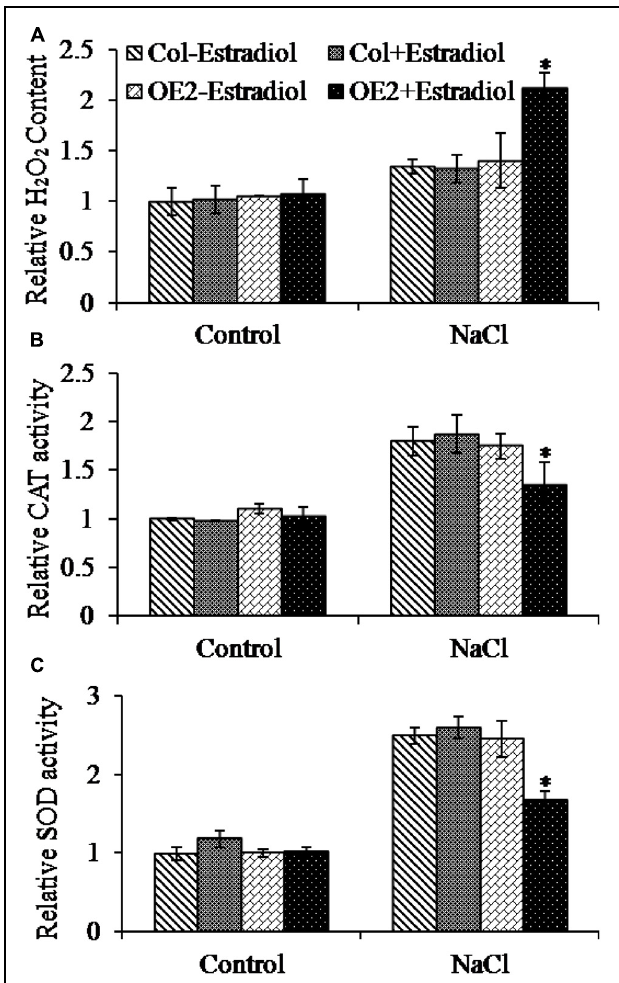
FIGURE 5 | Determination of relative H 2 O 2 content and antioxidant enzyme activities in Col and OE2 plants. Asterisk symbols ( ∗ ) indicate p < 0.05 (Student t- test). The 5-day-old seedlings grown on MS plated were transferred into the indicated treatments for 7 days, and then the seedlings were collected for analyzing H 2 O 2 and antioxidant enzyme activities (NaCl, 100 mM; Estradiol, 10 μ M). Data are means ± SE of three independent measurements. (A) Comparison of H 2 O 2 contents in Col and OE2 plants after NaCl treatment. (B) and (C) Changes in CAT and SOD activities of Col and OE2 were